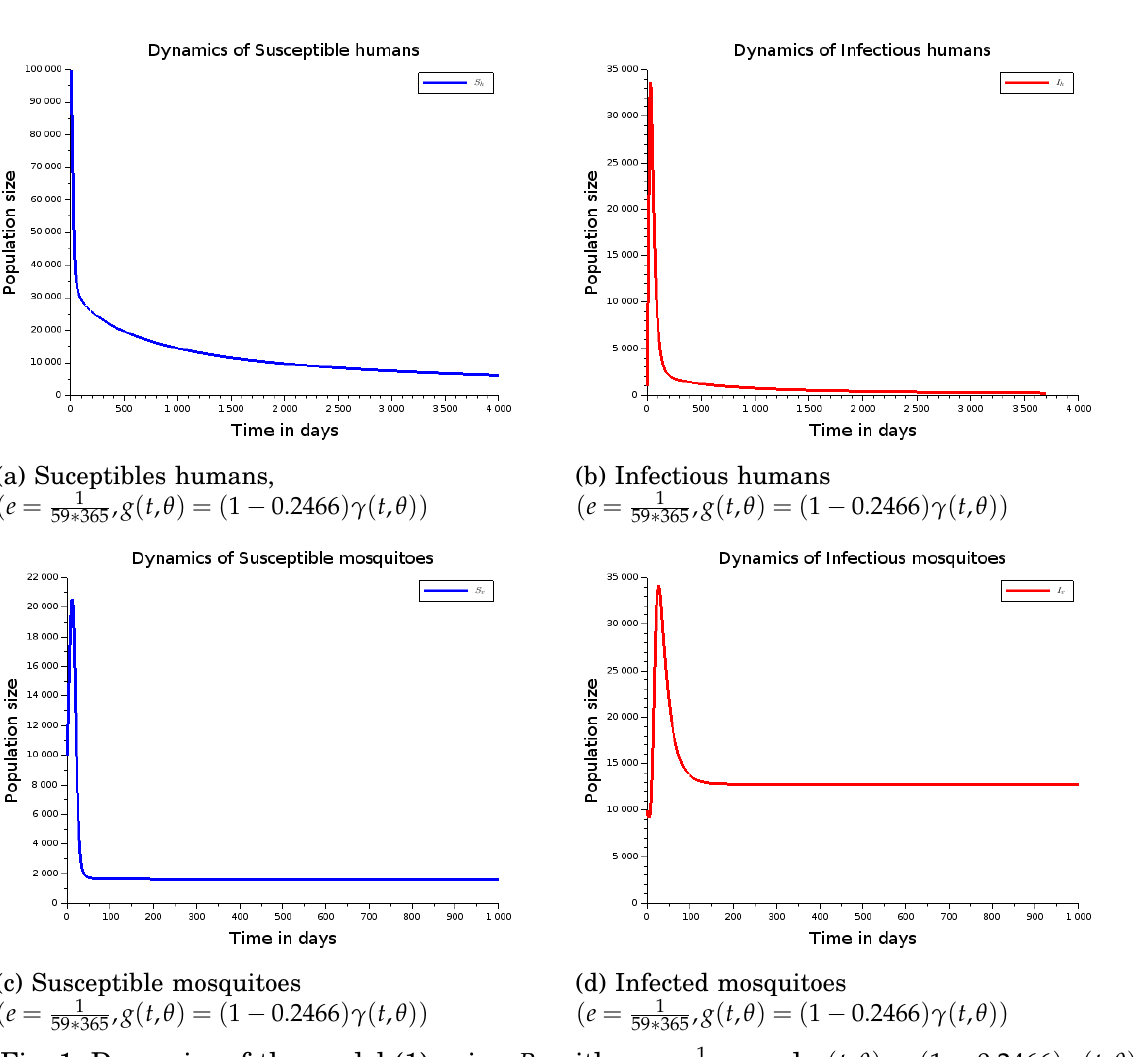
Fig. 1: Dynamics of the model (1) using P (cid:104) (cid:105) 1 level θ ∈ is greater than the proportion ;1 2 of recovered individuals with a premuni- p 2 (cid:104) (cid:105) tion level θ ∈ , and support the fact that 0, 1 2 the factor e and k are very